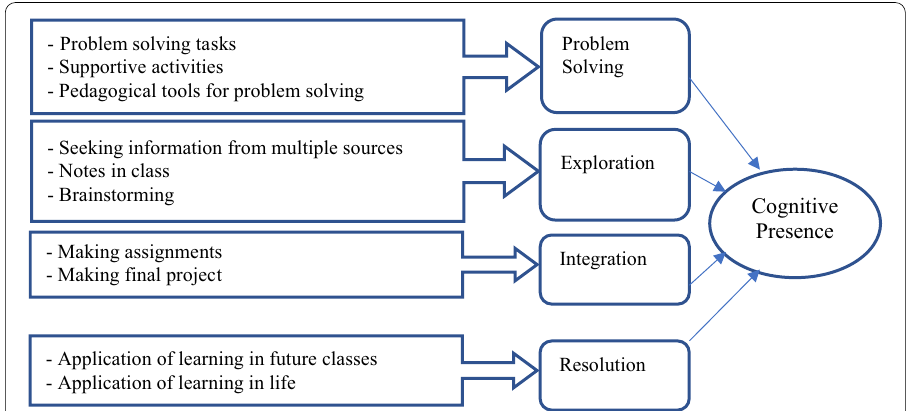
Fig. 2 Structure of students’ perceptions about cognitive presence in virtual learning